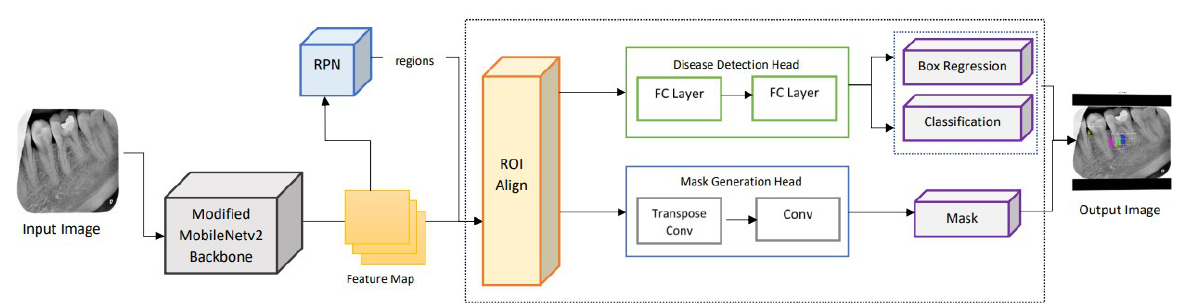
Figure 4. Architecture of the lightweight M-RCNN modified with MobileNet-v2 as its backbone.